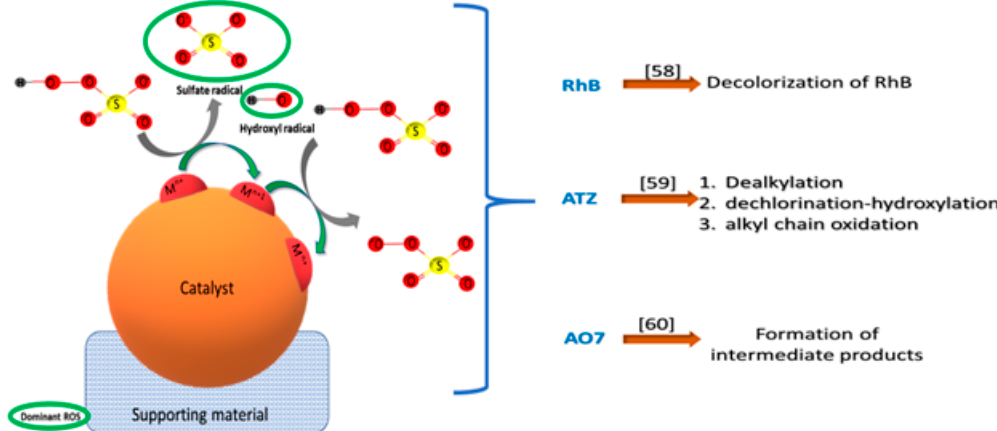
Figure 5. General catalyzed PMS radical acticvation mechanism by supported perovskites for the degradation of organic pollutants [61–63].